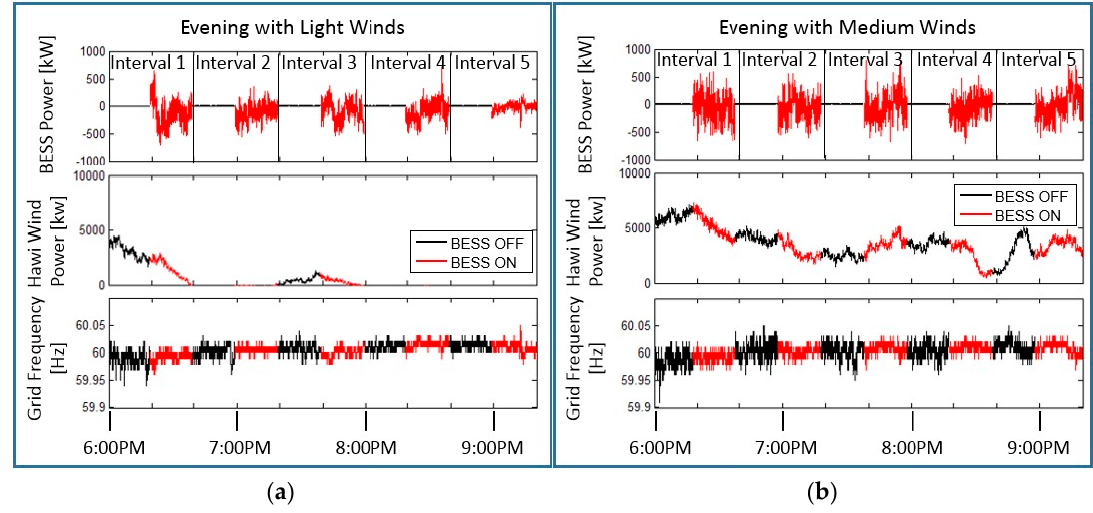
Figure 6. Top: BESS power output with a gain of 30MW/Hz; Middle: wind power generation; Bottom: and grid frequency on an evening with light winds ( a ) and an evening with medium winds ( b ). Black lines indicate the BESS is OFF and red lines indicate BESS is ON. The BESS was switched between OFF and ON every 20 min.